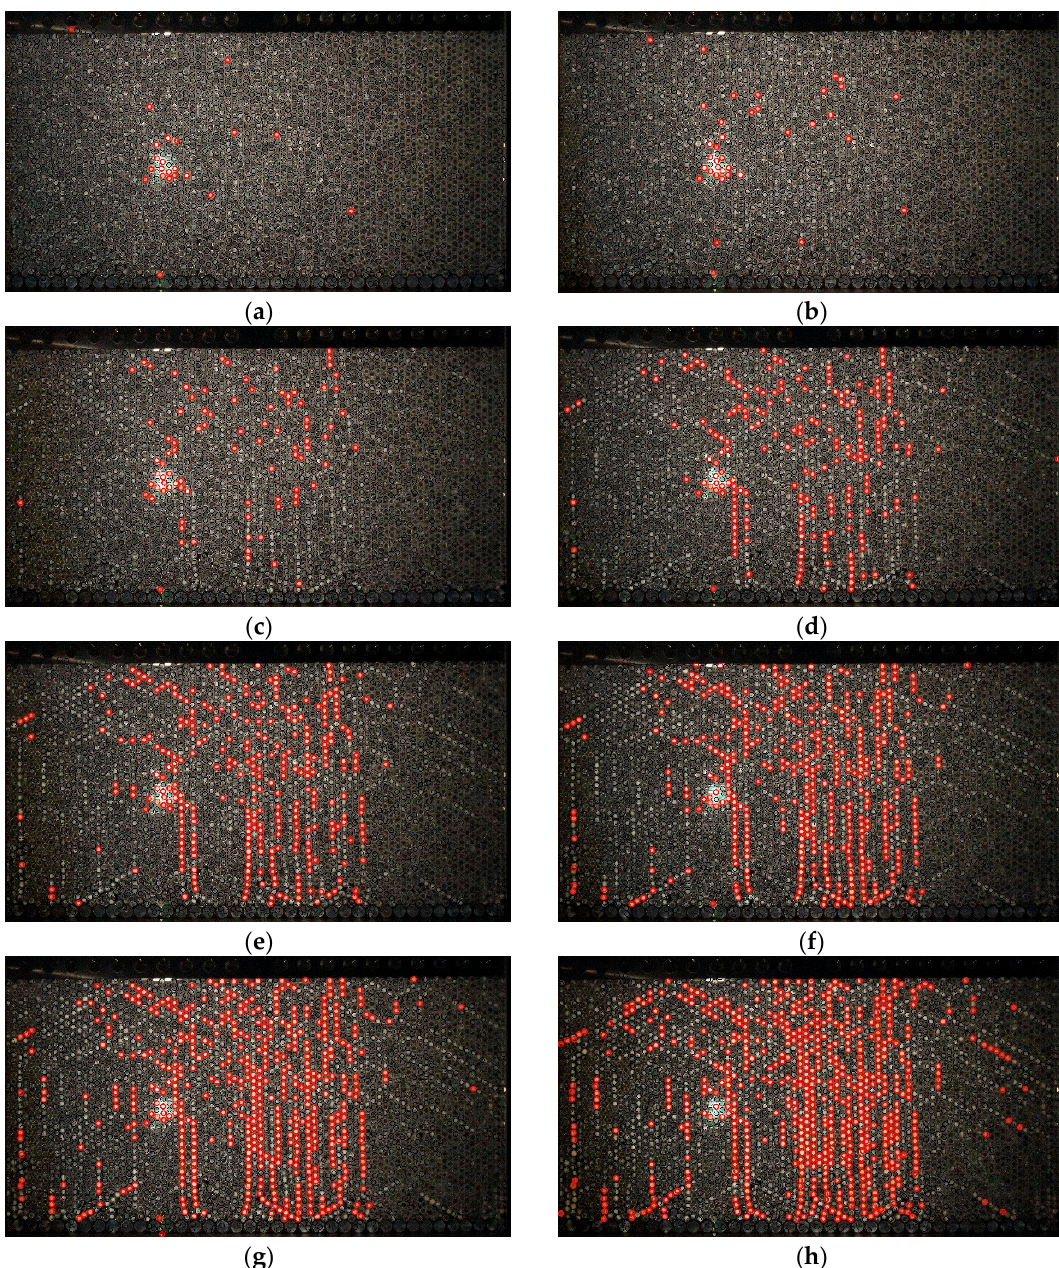
Figure 7. Contact force chains detected by red, green, and blue (RGB) photoelastic digital image analysis during uniaxial loading of a uniform structure: (a) before loading; (b) F = 500 N; (c) F = 1000 N; (d) F = 1500 N; (e) F = 2000 N;(f) F = 2500 N; (g) F = 3000 N; (h) F = 4000 N. Primary contact force chains are marked as red circles, particles with forces <100 N are shown as black circles.